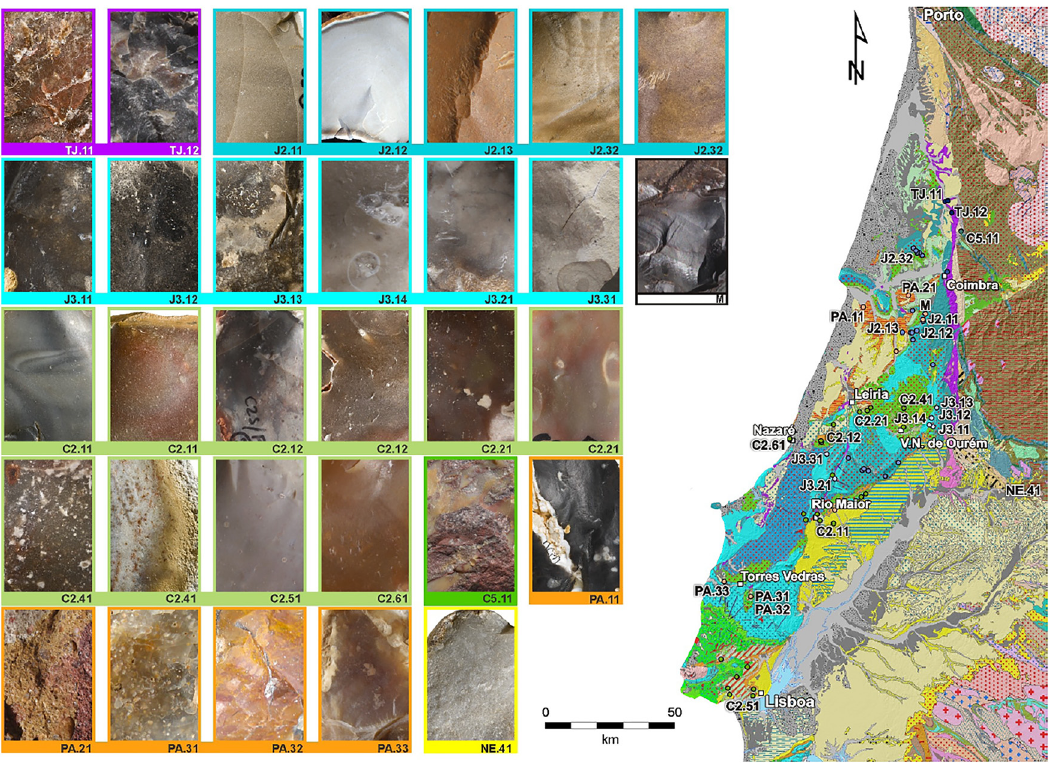
Figure 13: Map of the main fl int and siltstone sources from the West Portuguese Meso - Cenozoic Border during Prehistoric times ( from Aubry, 2018, p. 16 )